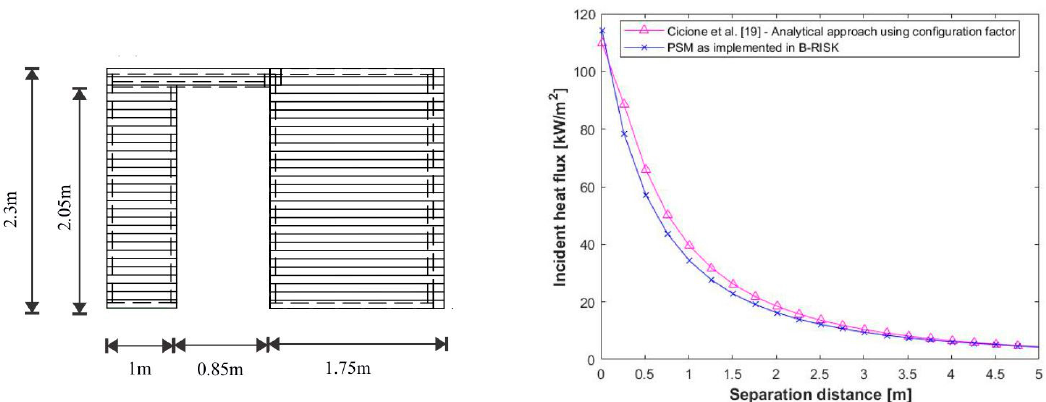
Figure 5. Comparison of the radiation emitted from an informal settlement dwelling (ISD) as calculated using the PSM and Equation (5) (refer to Reference [19] for more details on the analytical method).